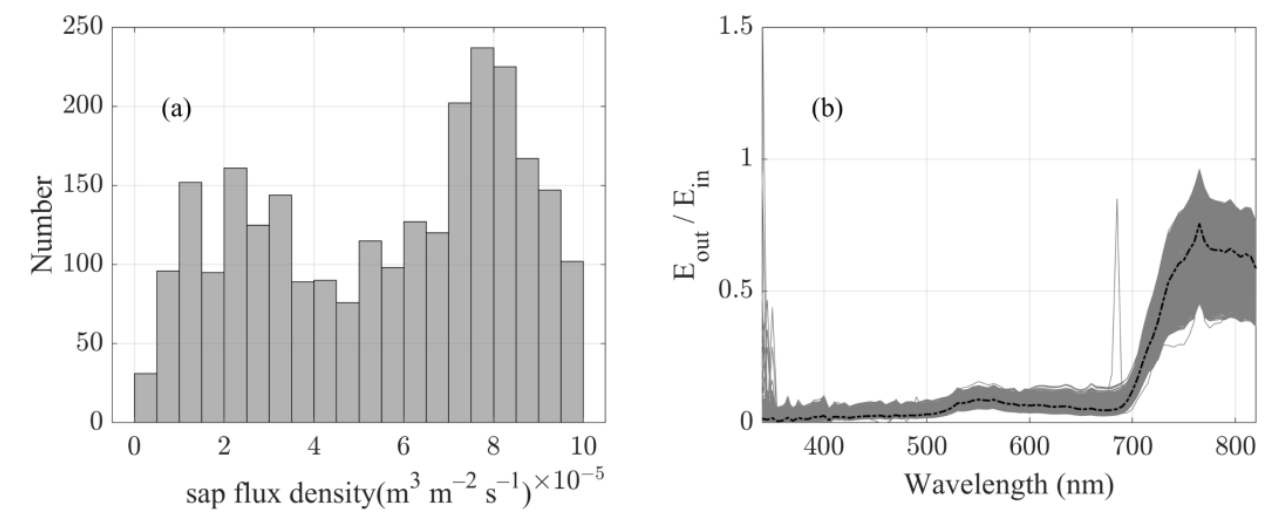
Figure 2. Variations of field-measured sap flux density ( a ) and spectra in 5 nm resolution ( b ). The diurnal variations of sap flux density (10-min and hourly) under different